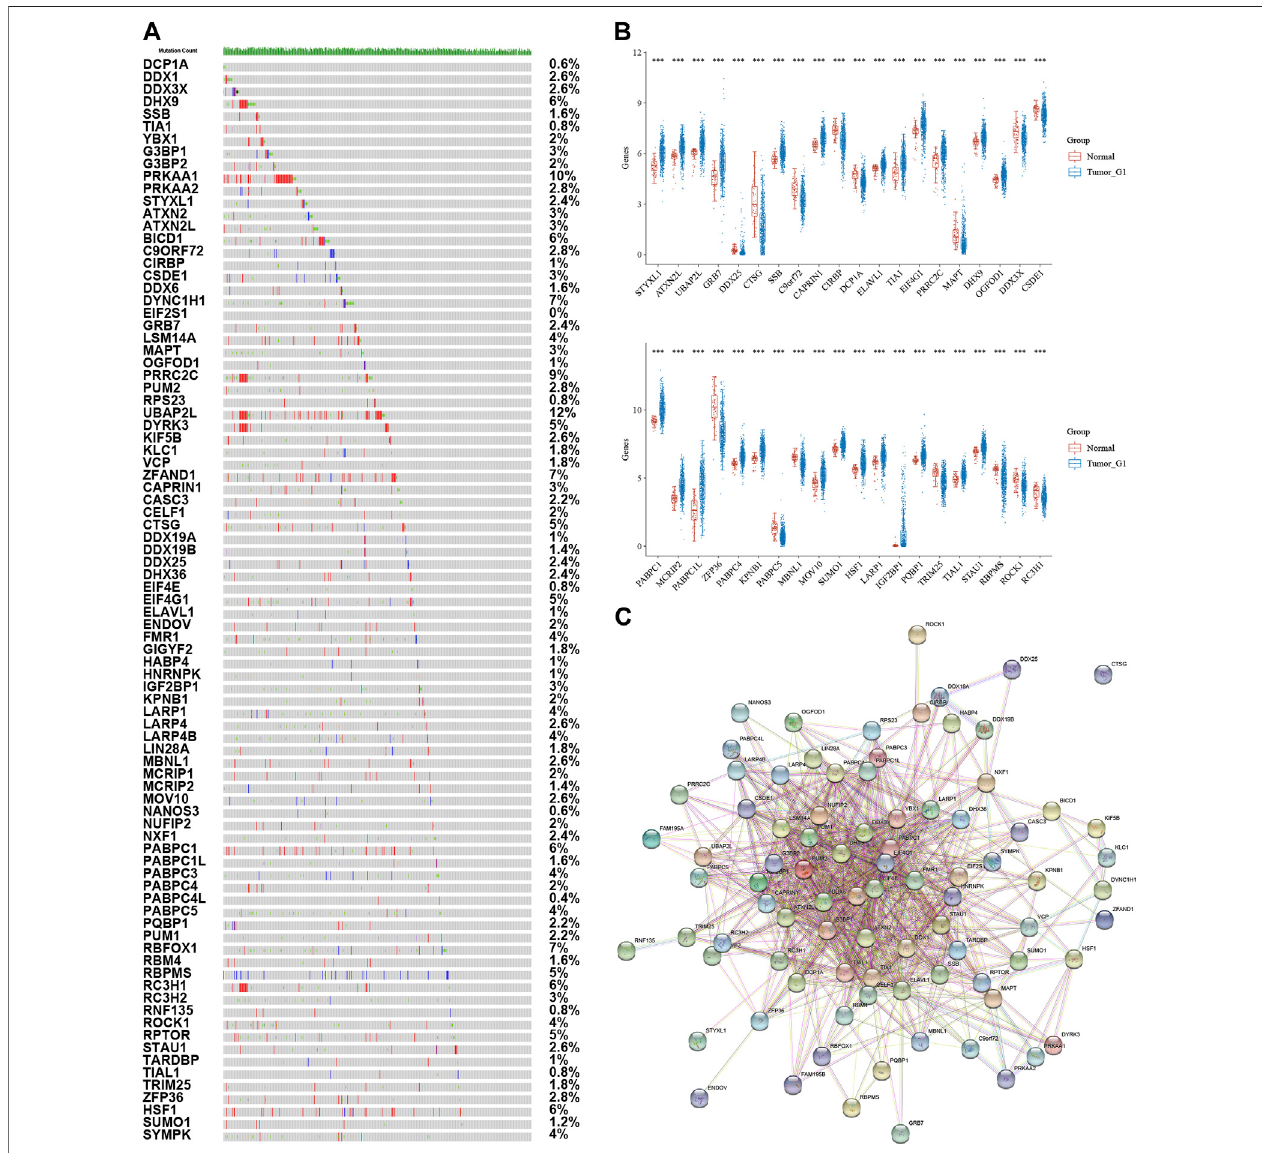
FIGURE2| AnalysisofStressGranuleRegulatorsMutationandExpressionPatternsinNSCLC. (A) geneticvariantsofstressgranuleregulatorsinNSCLCsamples using Cbiopotal database. (B) Stress granule regulators were differently expressed in NSCLC samples. (C) Protein – protein interaction networks revealed that these stress granule-related proteins commonly interacted with one another.